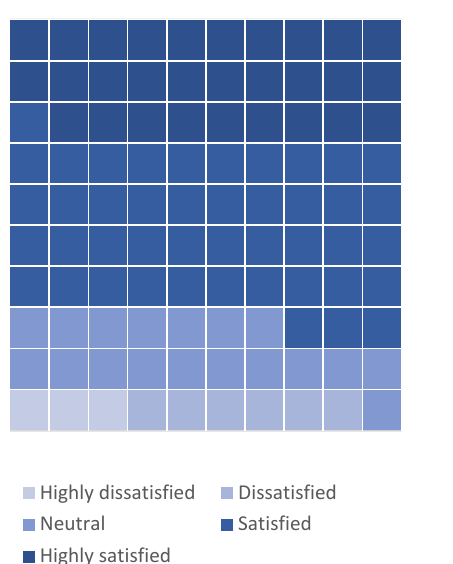
Figure 2. The mean and standard deviation of car service quality attributes.